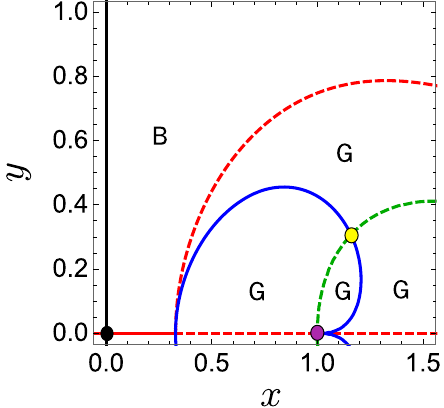
FIG. 6. Critical initial condition set F − 1 ð Σ Þ , shown in the ð x; y Þ 0 , for the nominal insert strength p plane with p x ¼ y ¼ τ ¼ − 0 . 4 . Only one quadrant is shown. (Results are symmetric about the x - and y -axes.) Colors and labels correspond to those found in Fig. 3. This set includes one stable fixed point (black dot, origin) and four unstable fixed points (yellow dots, one visible). The visible singular point is located at (1,0) (purple), but is not considered part of the phase space M . A particle with its initial condition on one of the solid curves executes a stable periodic